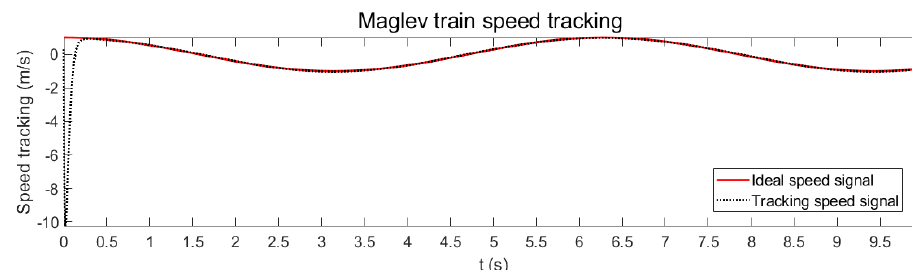
Figure 10. Maglev train displacement tracking curve.